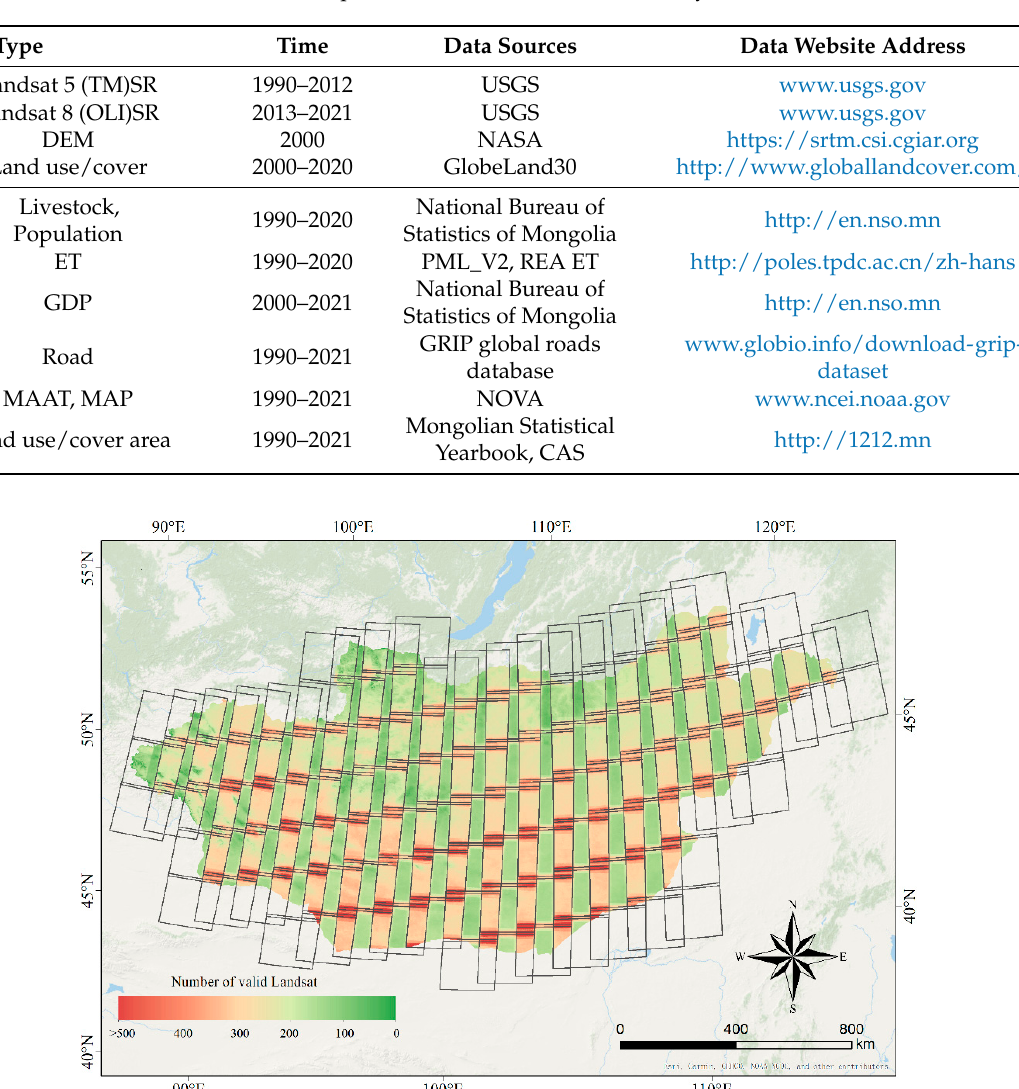
Table 1. Data source description (All data accessed on 1 January 2022).